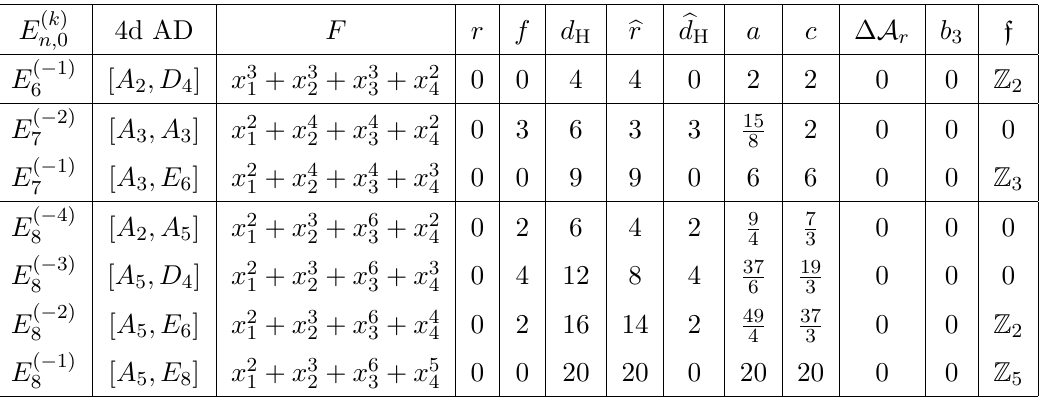
Table 2 . Terminal singularities ( r = 0 models) of type E ( k ) n , with k < 0 , corresponding to [ G, G 0 ] AD theories as indicated. Note that ∆ A